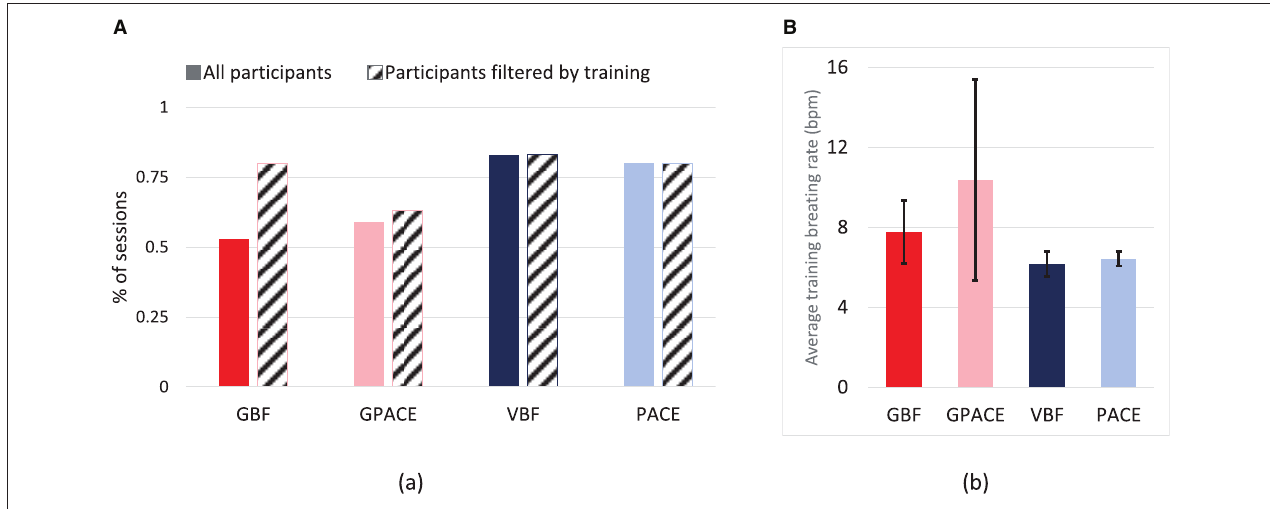
FIGURE 9 | (A) Percentage of treatment sessions where the breathing rate of the last 30s was in the effective breathing range (6BPM ± 0.9BPM) for participants, and only the participants with average training breathing rate in the effective dosage range. (B) Average breathing rate (BPM) during training session for all